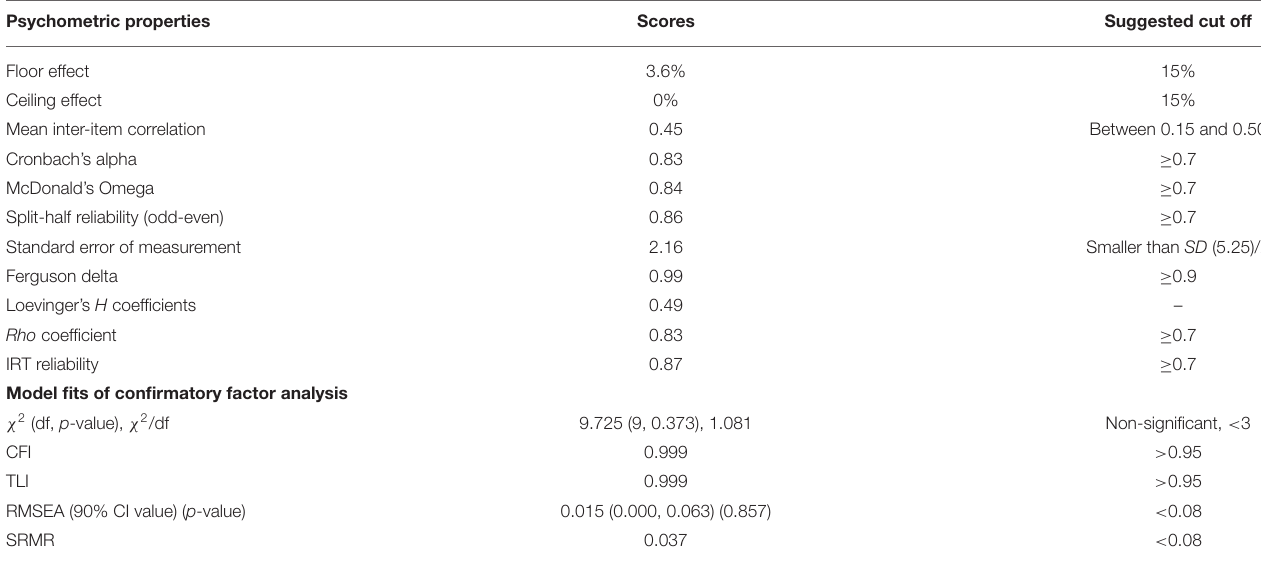
TABLE 3 | Scale-level psychometric properties of the Bangla version of the SAVE-6 scale. Psychometric